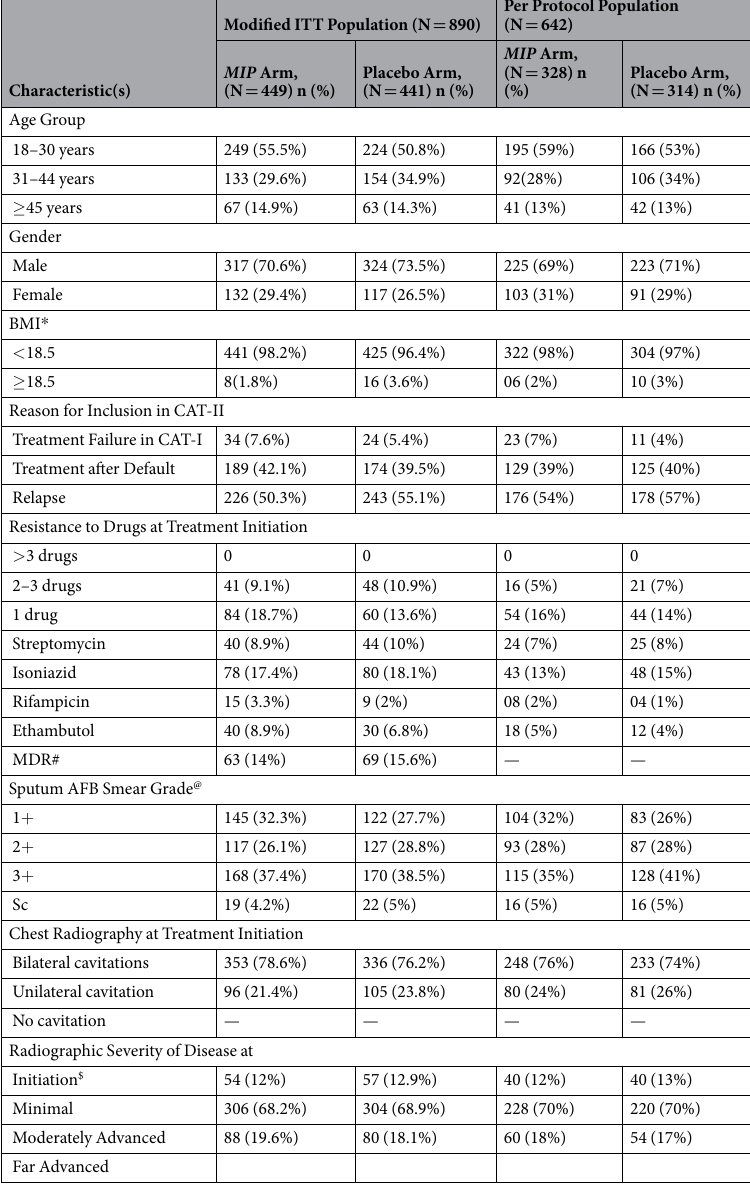
Table 1. Distribution of patient characteristics at baseline for Modified intent to treat (ITT, N = 890) and Per Protocol (N = 642) population who completed the treatment. * BMI- body mass index [weight in kg/